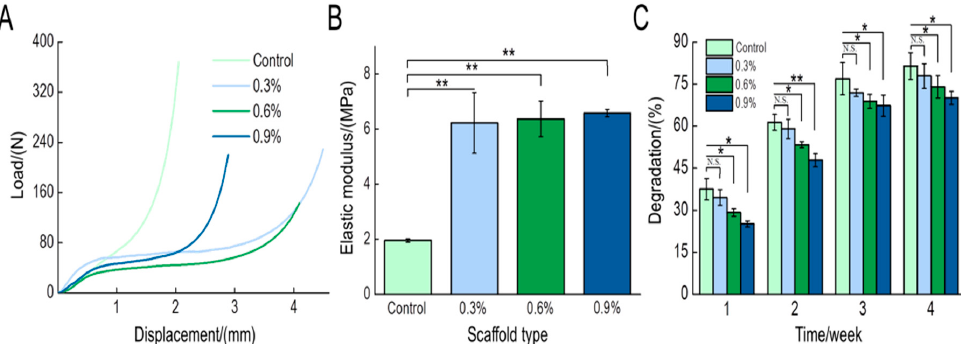
Figure 5. ( A ): The load-displacement curve of the CS/Gel/nHAp/MWCNTs scaffolds. The addition of MWCNTs alters the mechanical strength of the scaffold. ( B ): The elastic modulus of the CS/Gel/nHAp/MWCNTs scaffolds. The addition of MWCNTs significantly increased the elastic modulus of the scaffold. ( C ): The degradation rate of the CS/Gel/nHAp/MWCNTs scaffolds. The degradation rate gradually increased over time but decreased with increasing MWCNTs content at the same time. Data indicate mean ± SD. N.S: p > 0.05, * p < 0.05, ** p < 0.01.